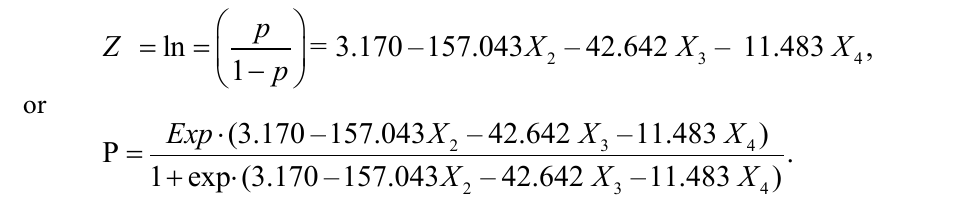
Table 4. Regression